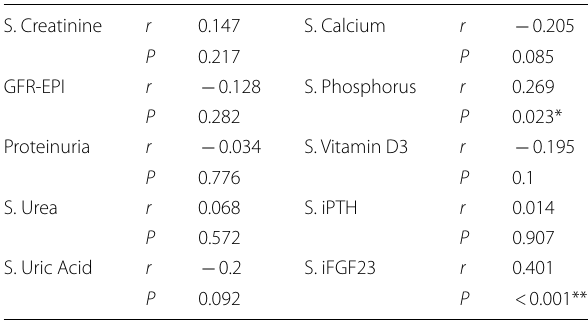
Table 5 Other correlations of hypertension grade in CKD patients